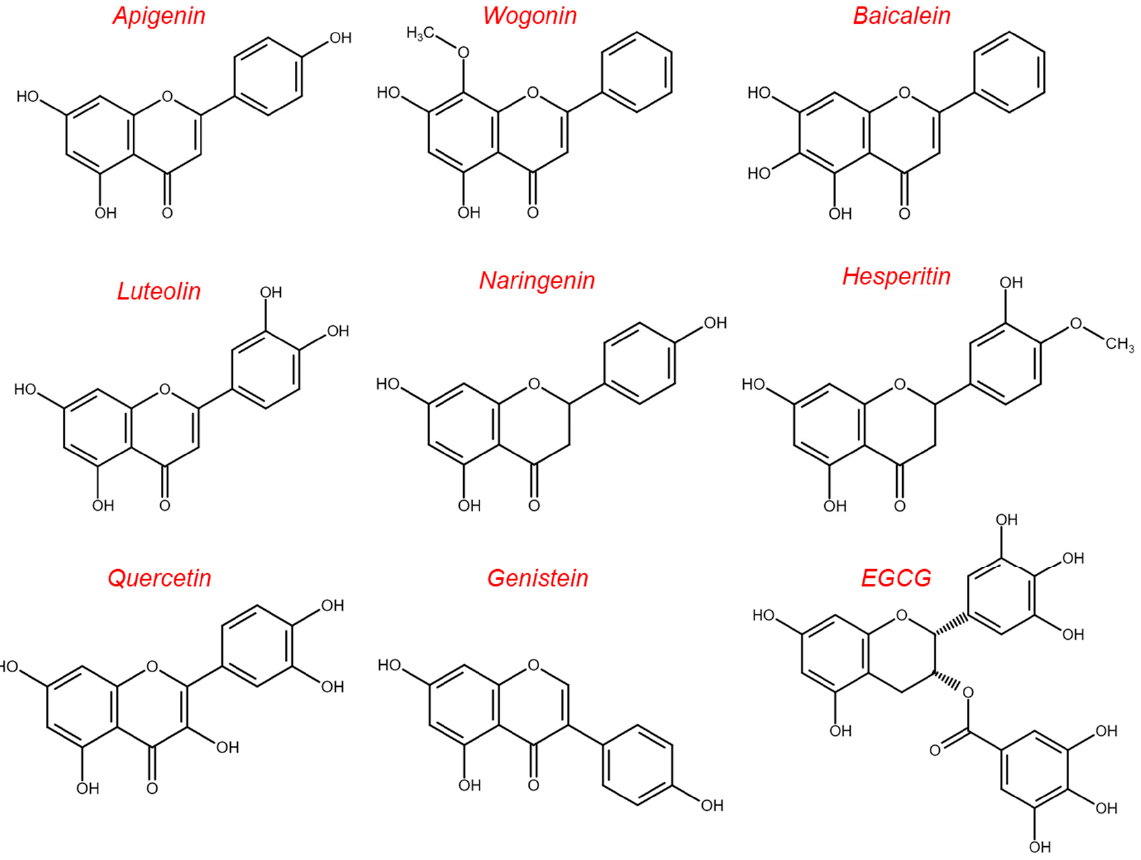
Figure 7. Chemical structure of principal flavonoids discussed in this section. EGCG, epigallocatechin gallate.